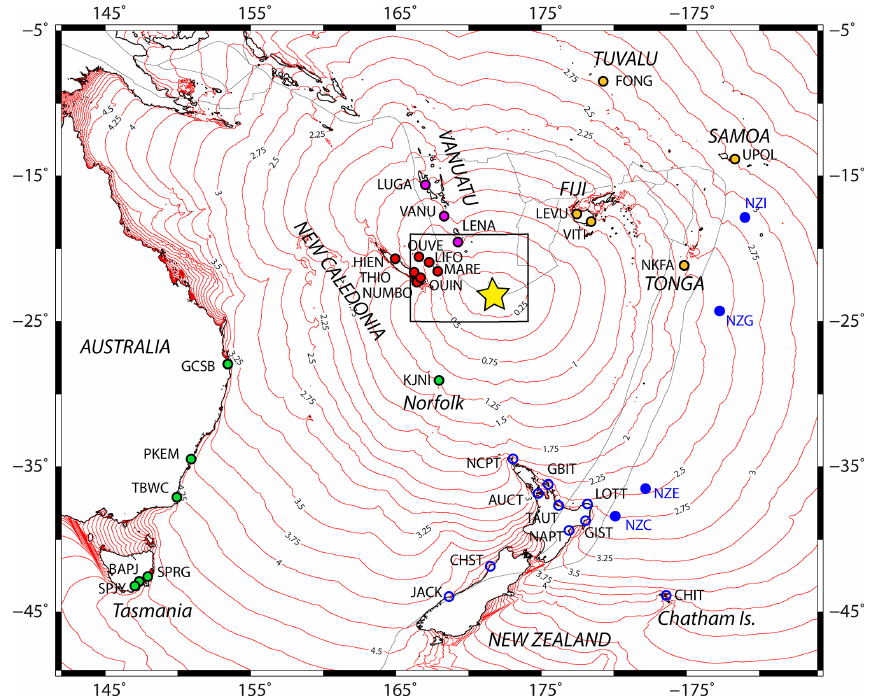
Figure 5. Location of the coastal gauges having recorded the 10 February 2021 tsunami and computed tsunami travel times (TTT) at a regional scale (in hours). Coloured circles show the location of the stations (blue: New Zealand – blue contour: coastal stations; full blue: DART stations; green: Australia; red: New Caledonia; purple: Vanuatu; orange: other countries) which recorded the tsunami; red lines represent the TTT isolines with a time step of 15min calculated using MIRONE software (Luis, 2007). The yellow star locates the earthquake’s epicentre; light grey lines represent the tectonic plate boundaries (provided by GMT software; Wessel et al., 2019). The black rectangle locates the extent of Fig.